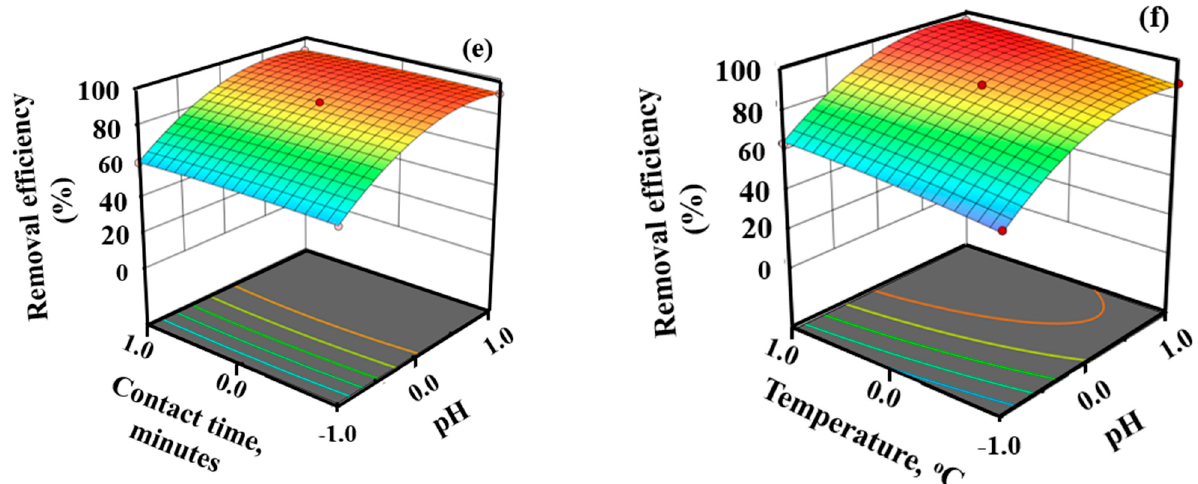
Figure 6. ( a ) VSM, ( b ) DRS plot, ( c ) photoluminescence spectra of MGF–B, BPGO and HNFs, Removal efficiency of Pb(II) as a function of ( d ) pH and adsorbent dose, ( e ) pH and contact time and ( f ) pH and temperature.